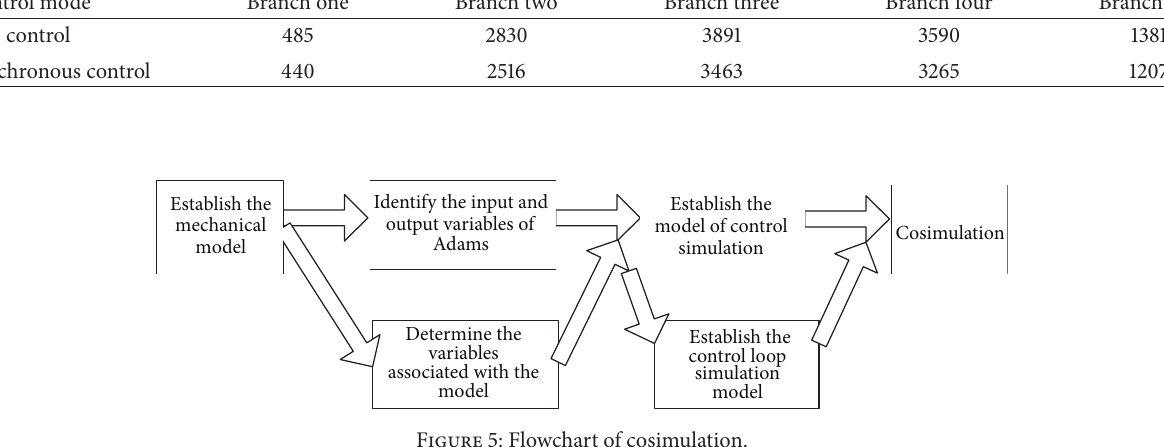
Figure 5: Flowchart of cosimulation.